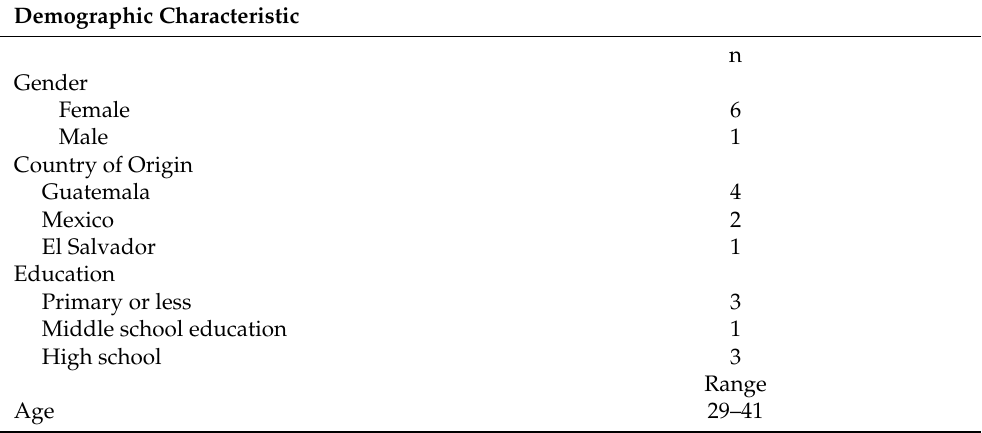
Table 1. Demographic characteristics of participants.